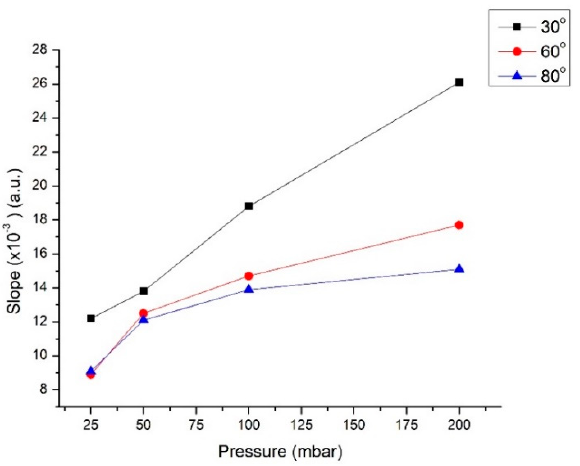
Figure 5. Slope of the linear interpolation of the intensity profile of the visual diffusion analysis (see Figure 3c) in the chip as a function of the pair inlet pressure at the different separation angles θ = 30°, 60°, and 80°.